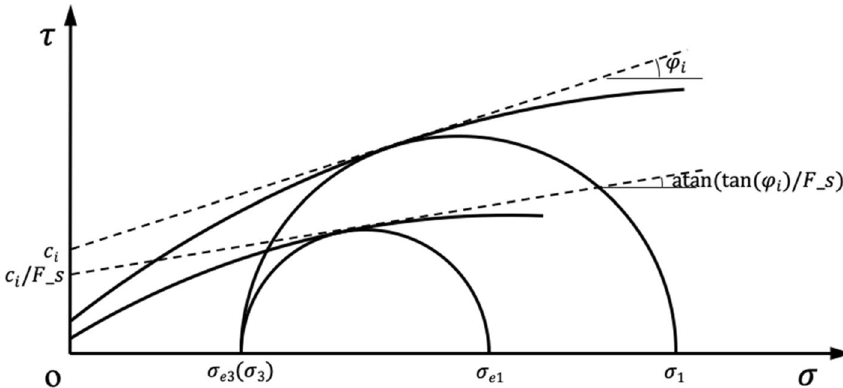
Figure 4. Reduction calculation sketch.